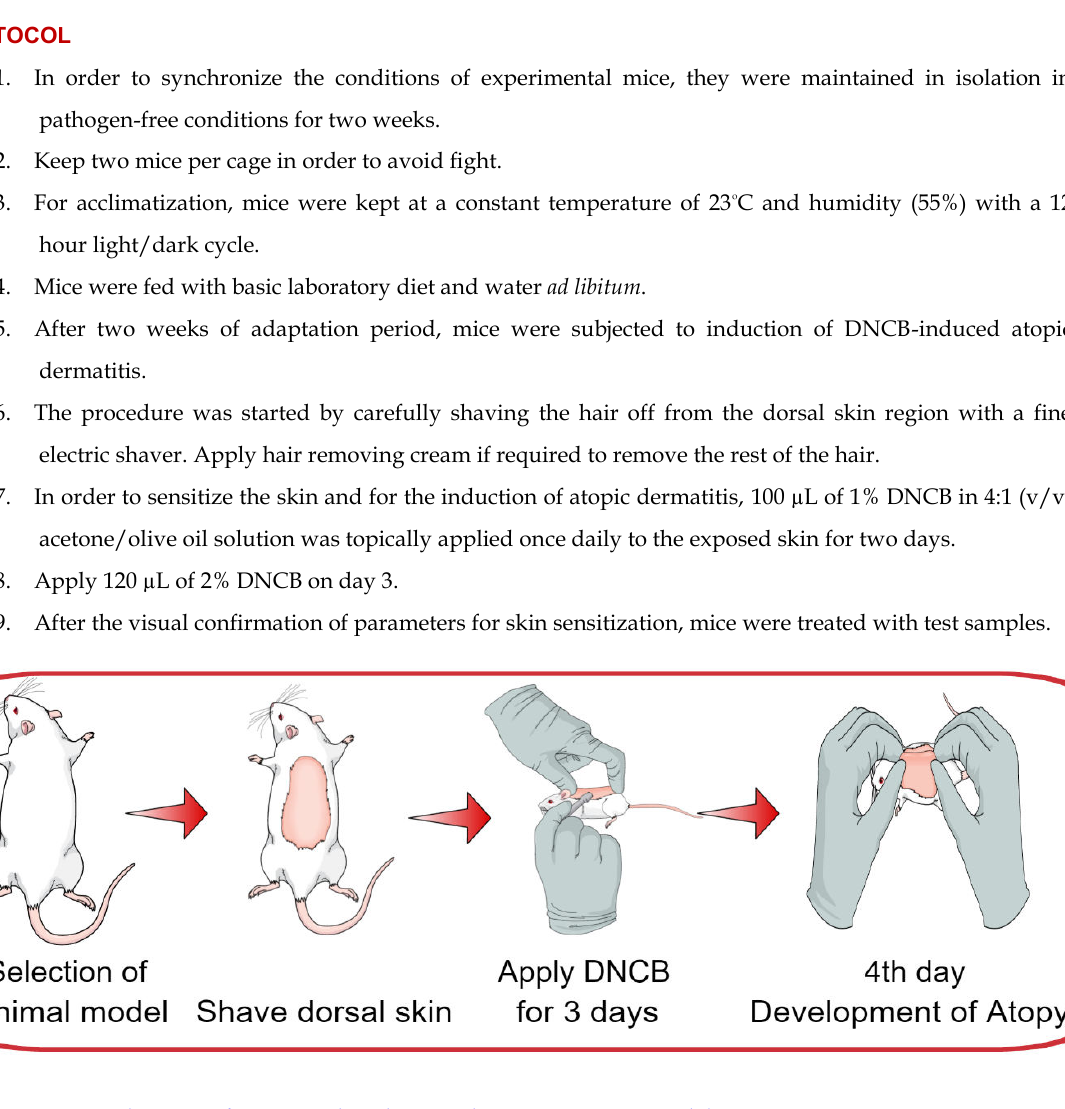
Figure 1: Schematic of DNCB-induced atopic dermatitis in mice